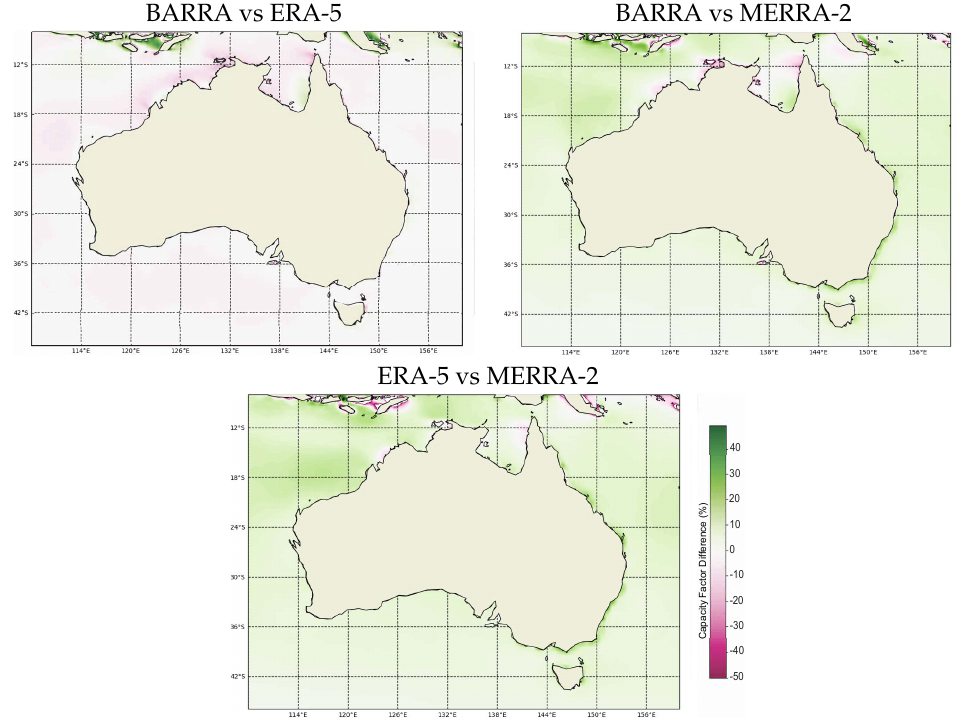
Figure 4. Percentage differences in average capacity factors (2009-2018) predicted by the datasets. The temporal variation of the capacity factors at these locations was then